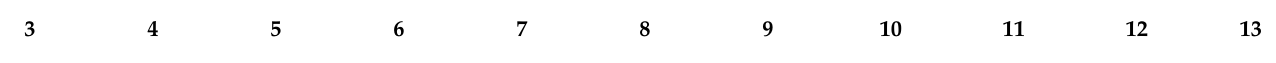
Table 1. Pearson correlations among variables, descriptive statistics, and t Student